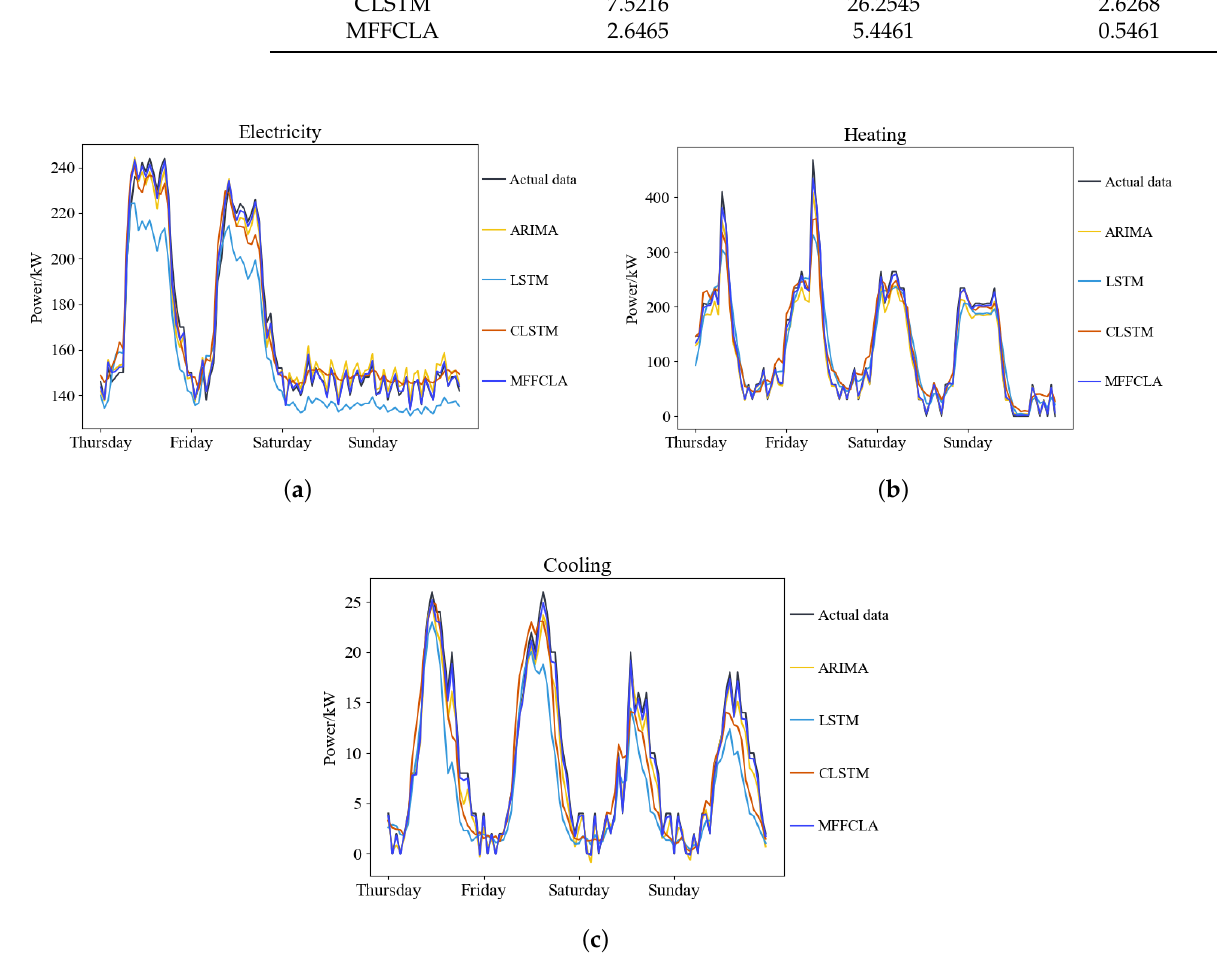
Figure 10. Multi-energy load forecasting curves. ( a ) The curve of electricity load forecasting results of each model. ( b ) The curve of heating load forecasting results of each model. ( c ) The curve of cooling load forecasting results of each